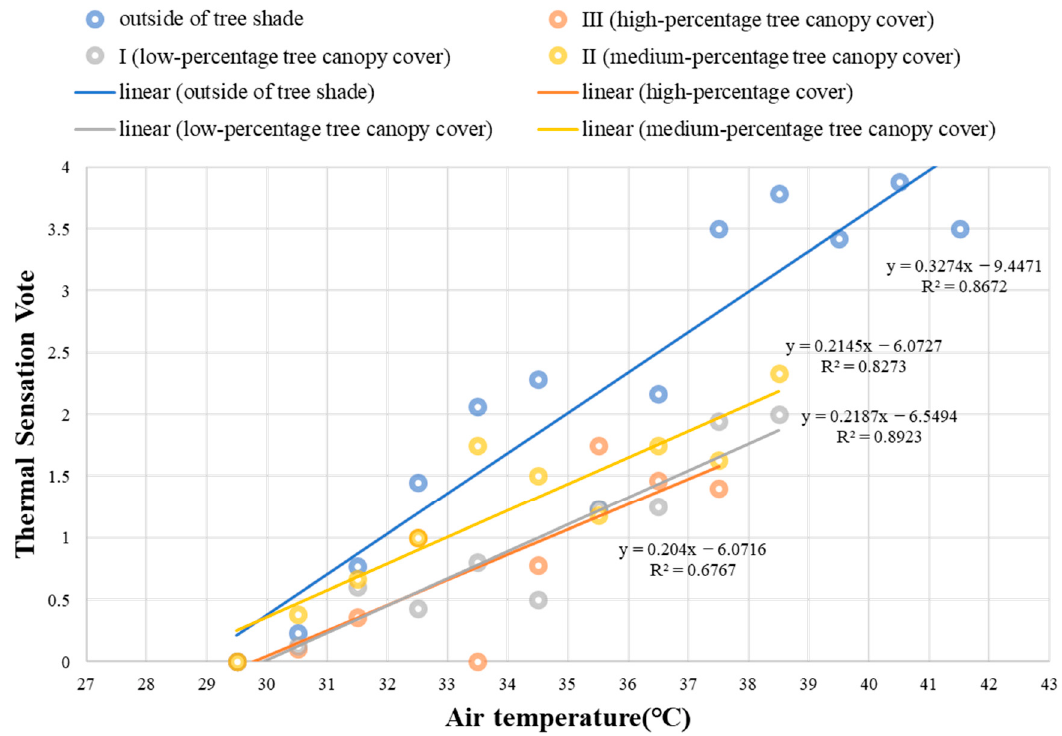
Figure 8. Correlation between thermal sensation vote (TSV) and air temperature (°C) in degrees of tree canopy cover.